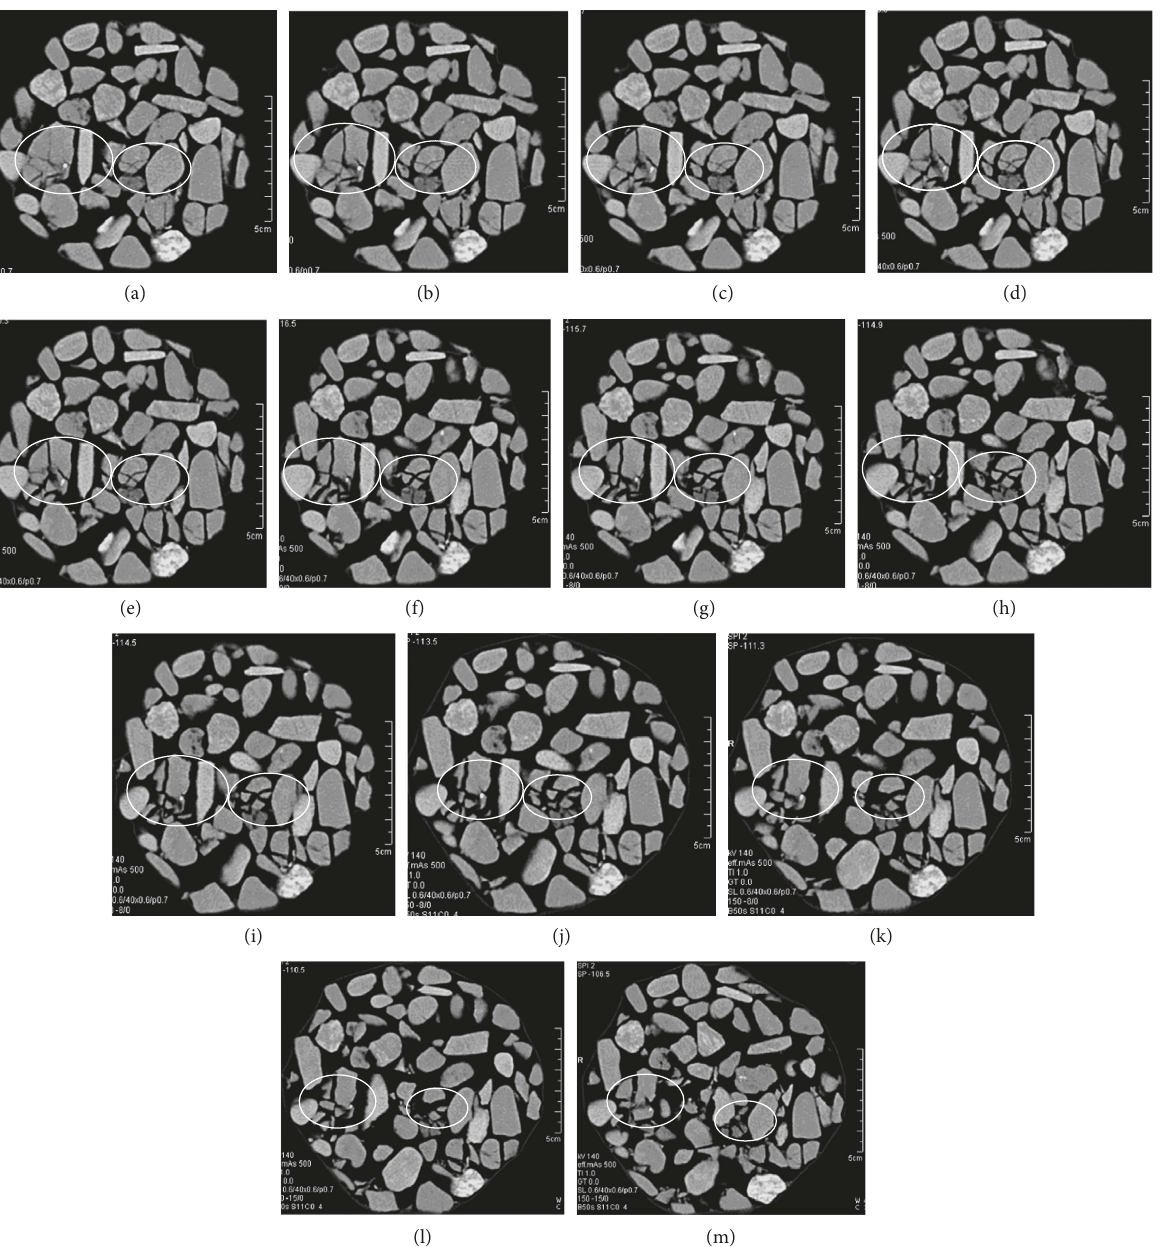
Figure 6: Cross-sectional images of the test sample ( σ 3 (cid:30) 200kPa). (a) Initial. (b) ε a (cid:30) 1.2%. (c) ε a (cid:30) 2.2%. (d) ε a (cid:30) 3.2%. (e) ε a (cid:30) 4.2%. 5.2%. (g) ε a 6.2%. (h) ε a 7.2%. (i) ε a 8.2%. (j) ε a 9.2%. (k) ε a 11.7%. (l) ε a 13.1%. (m) ε a (f) ε a (cid:30) (cid:30) (cid:30) (cid:30) (cid:30) (cid:30) (cid:30)